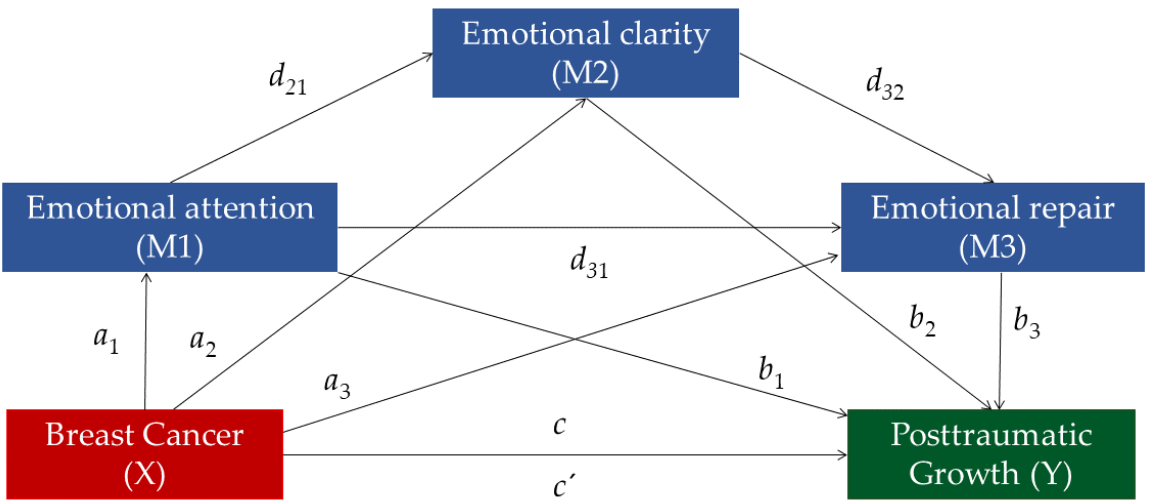
Figure 1. Serial Multiple Mediation Analysis in a statistical diagram with the three mediators (Emotional Attention, Emotional Clarity, and Emotional Repair).